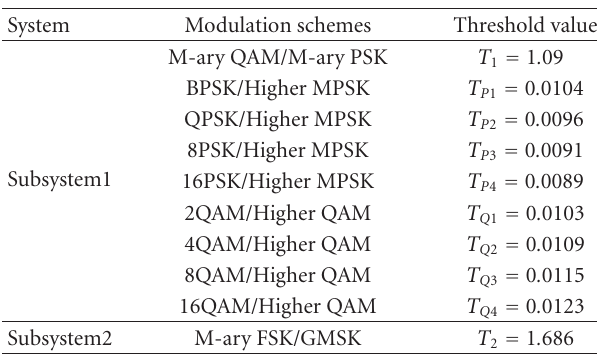
Table 2: Threshold